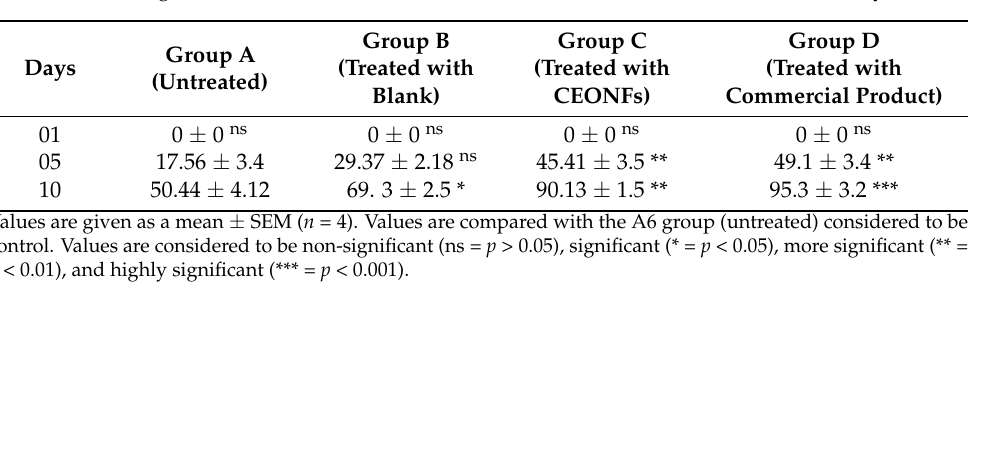
Table 4. Percentage wound contraction of wounded skin treated with NFs on different